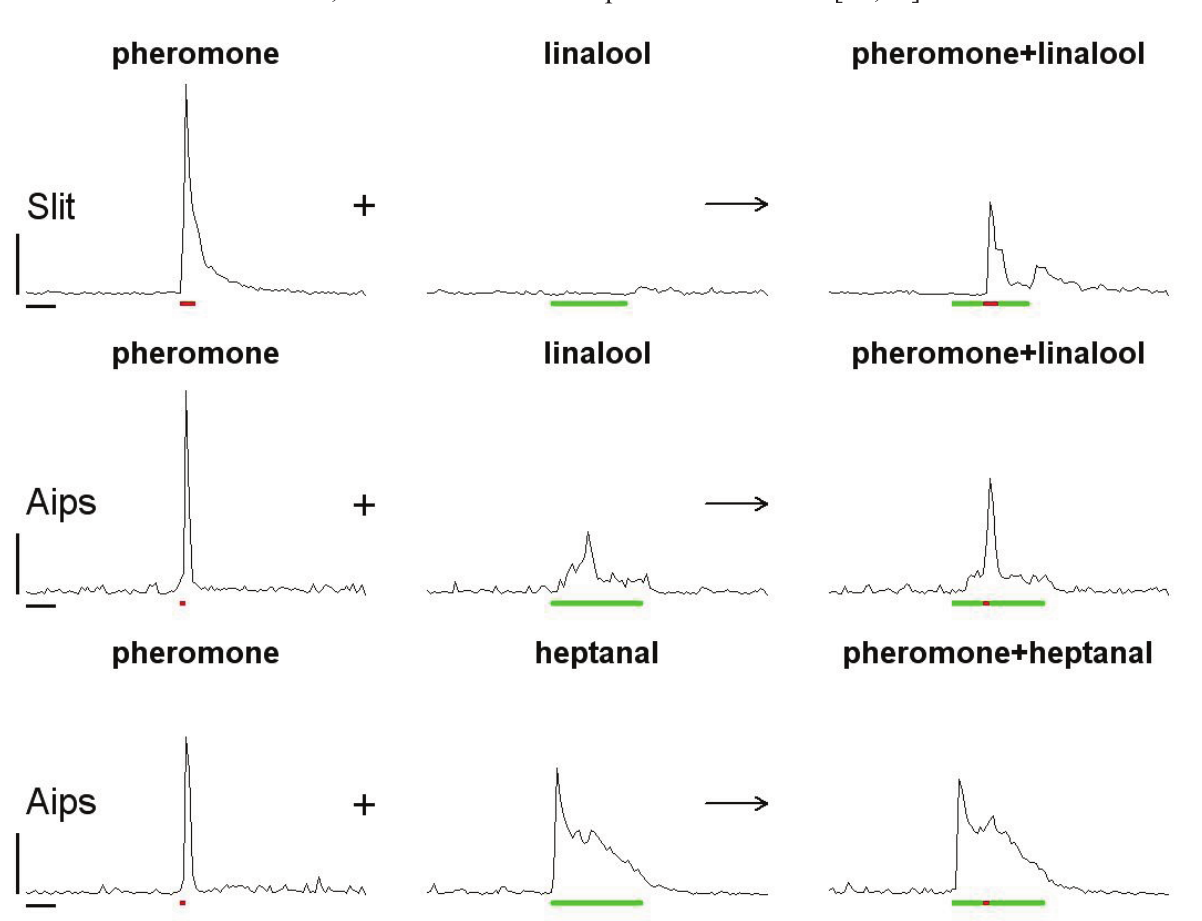
Figure 2. A background of a plant volatile affects the intensity and the dynamics of the responses to a pheromone pulse by specialist olfactory receptor neurons in moth antennae. Instantaneous spike frequencies calculated as the slope of a cumulative function [21] are shown over time for typical Phe-ORNs. In Spodoptera littoralis (Slit, upper row ) pheromone specialized neurones respond to a short pulse of the main pheromone component (Z9,E11-14:Ac) by a step increase in their firing response ( left ); a prolonged stimulation with linalool does not increase spontaneous firing ( middle ); simultaneous presentation of linalool and pheromone results in reduced peak firing frequency, narrowing of the response and a post-background rebound. While linalool acts as an antagonist of pheromone reception in S. littoralis , it is a weak agonist in Agrotis ipsilon leading to weak activation as single stimulus and mixture suppression together with pheromone (Aips, middle row). The component of linden flower aroma, heptanal, strongly stimulates Pher-ORNs (agonism, Aips, lower row) in A. ipsilon but masks the response to a pheromone pulse. Red bars = pheromone stimulation; green bars = volatile plant compound stimulation. Graphs present the frequency curves averaged on responses recorded from 10 to 20 different sensilla. Horizontal scale bar 1 s, vertical scale bar 50 spikes/s. Data from